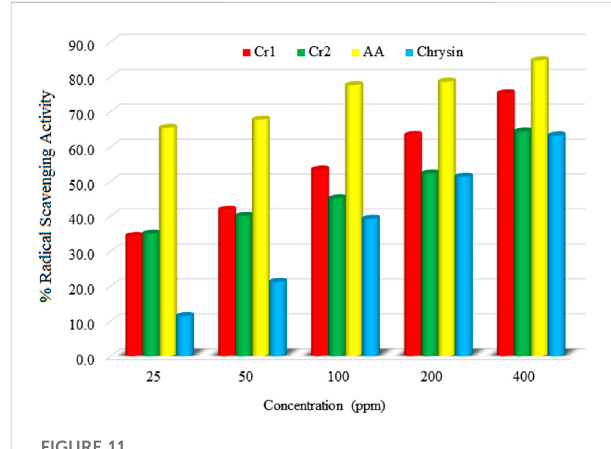
FIGURE 11 Antioxidant pro fi les of the synthesized metal complexes ( Cr1 and Cr2